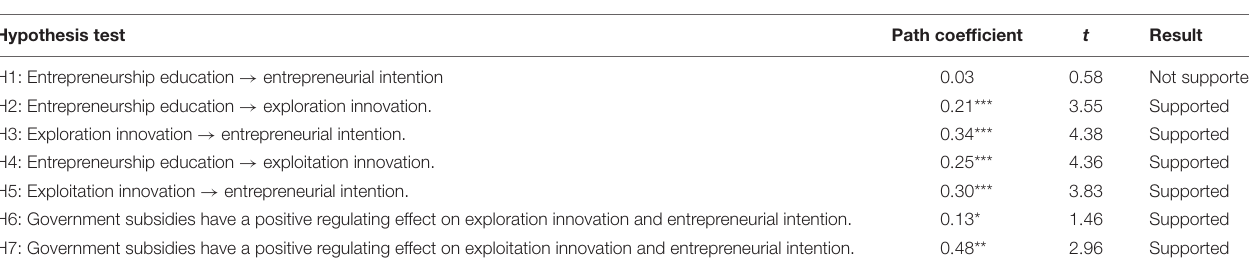
TABLE 3 | Hypothesis test and result.